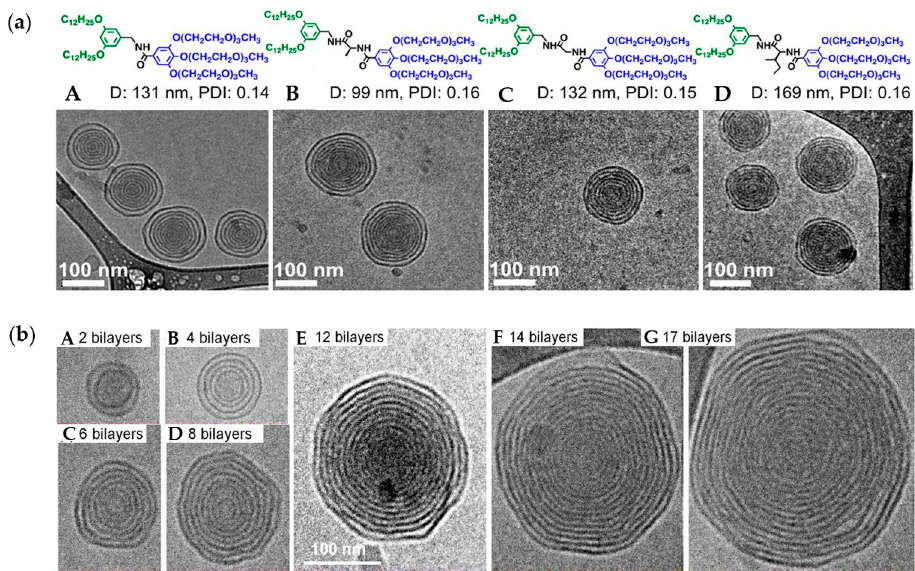
Figure 12. ( a ) Representative cryo-TEM images of onion-like vesicles self-assembled by injection of THF solution of: ( A ) (3,5)12G1-CH 2 -NH-(3,4,5)-3EO-G1-(OCH 3 ) 3 ; ( B ) (3,5)12G1-CH 2 - l -Ala-(3,4,5)- 3EO-G1-(OCH 3 ) 3 ; ( C ) (3,5)12G1-CH 2 -Gly-(3,4,5)-3EO-G1-(OCH 3 ) 3 ; and ( D ) (3,5)12G1-CH 2 - l -Ile-(3,4,5)- 3EO-G1-(OCH 3 ) 3 in water (1 mg/mL). ( b ) Cryo-TEM images of onion-like dendrimersomes self- assembled from (3,5)12G1-CH 2 - l -Ala-(3,4,5)-3EO-G1-(OCH 3 ) 3 in water at concentrations of: ( A ) 0.025 mg/mL; ( B ) 0.1 mg/mL; ( C ) 0.2 mg/mL; ( D ) 0.5 mg/mL; ( E ) 1 mg/mL; ( F ) 2 mg/mL; and ( G ) 2.5